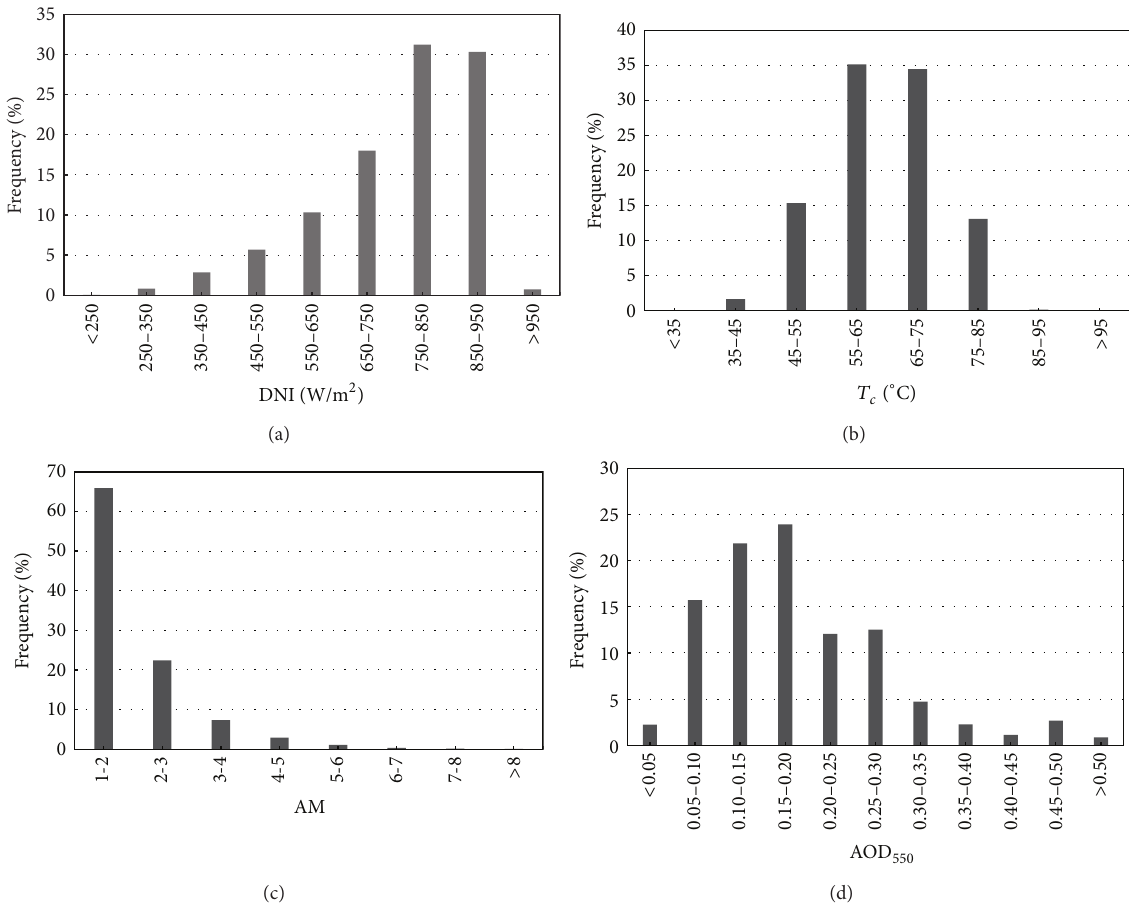
Figure 4: Frequency of the direct normal irradiance (a), the cell temperature (b), the air mass (c), and the aerosol optical depth at 550 nm (d) measured during the experimental campaign.